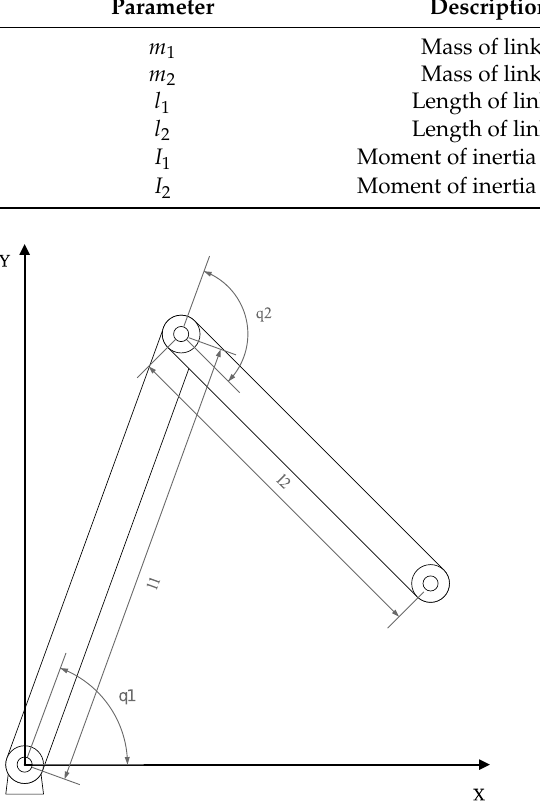
Figure 2. Sketch of two-link robot manipulator